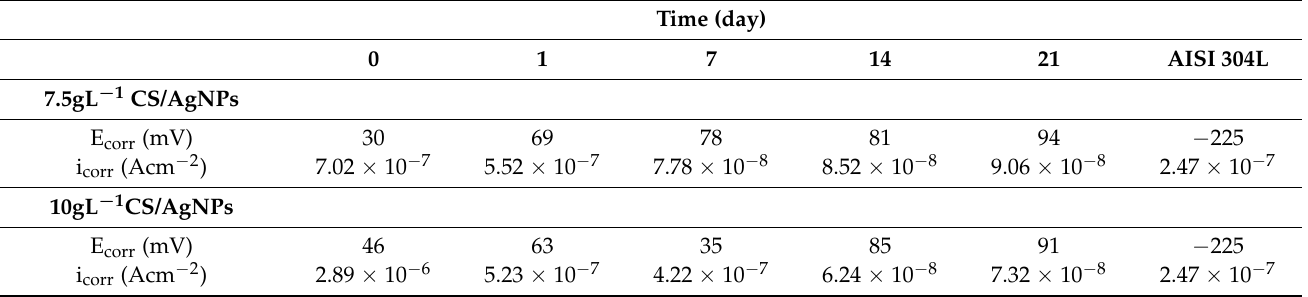
Table 1. Corrosion potential (E corr ) and corrosion current density (i corr ) extrapolated by Tafel curve for the coatings after different aging time in SBF.